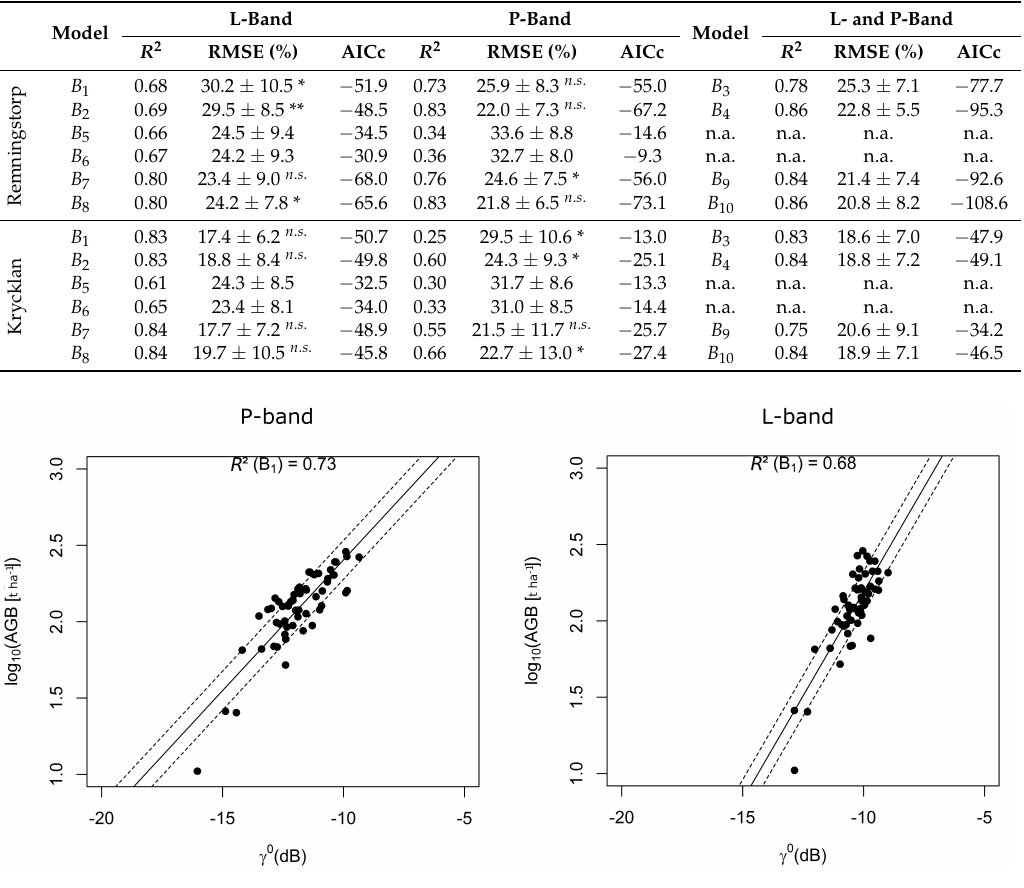
Figure 2. Log relationship between HV backscatter ( γ 0 [dB]) and aboveground biomass of forest stands for P- ( left ) and L-band ( right ) in Remningstorp (dashed line is for the uncertainty of the intercept; 2 May 2007). Table 4. Significance of coefficients (predictors) in the different aboveground biomass estimation models in Remningstorp/Krycklan ( B 1 to B 10 , see also Section 3.3 for a detailed description of the models and their coefficients, models with LP include both P- and L-band and * is for a p -value < 0.05, ** < 0.01 and *** < 0.001; n.s. means not significant with significance level α of 0.05; n.a. means not applicable and this predictor was not used in the respective model; Remningstorp results are based on acquisitions on 2 May 2007 and Krycklan results are based on 313 ◦